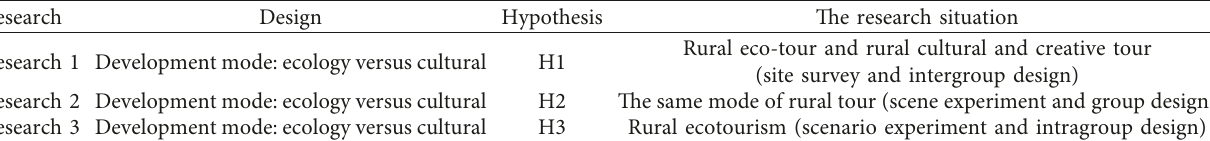
Figure 1: Theoretical Table 1: Research framework.